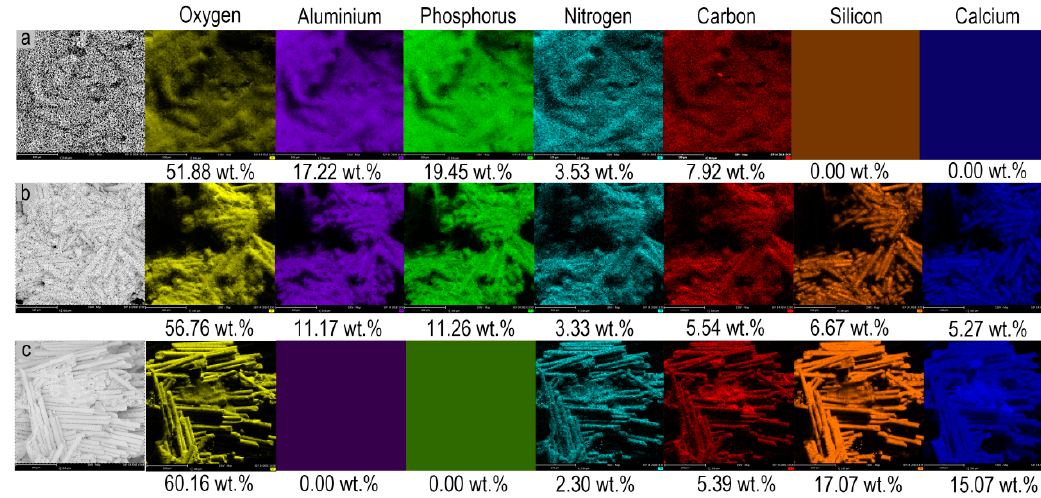
Figure 4. EDX scanned photos of surface residue from cone calorimeter tests ( a ) 5%API/7%ADP/GF/PA6; ( b ) 12%ADP/GF/PA6; ( c )